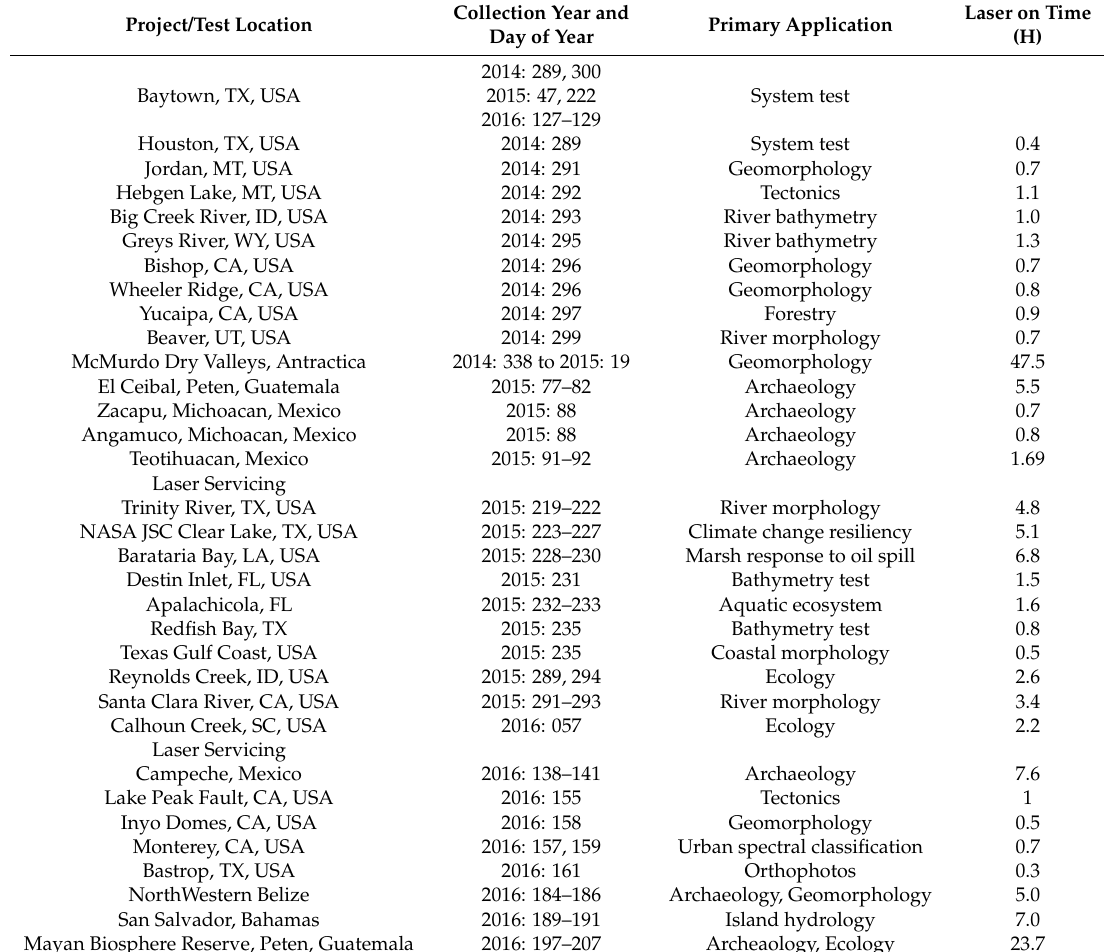
Table 2. Summary of projects and test collections to date with the Titan